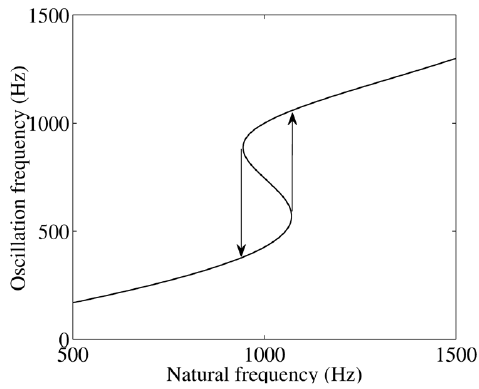
Figure 6. Oscillation frequency when moving across the fold in Figure 5. The arrows indicate fre- quency jumps, forming a hysteresis loop [20]. frequency jumps, forming a hysteresis loop